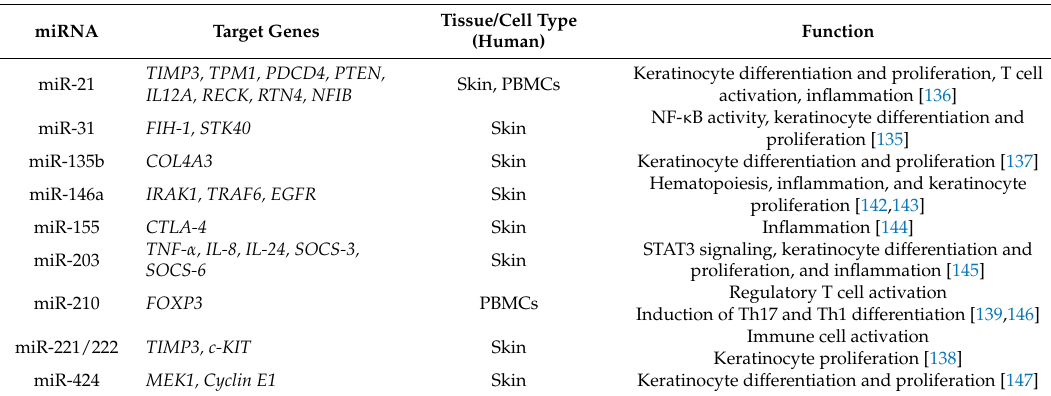
Table 1. MicroRNAs (miRNAs) increased in